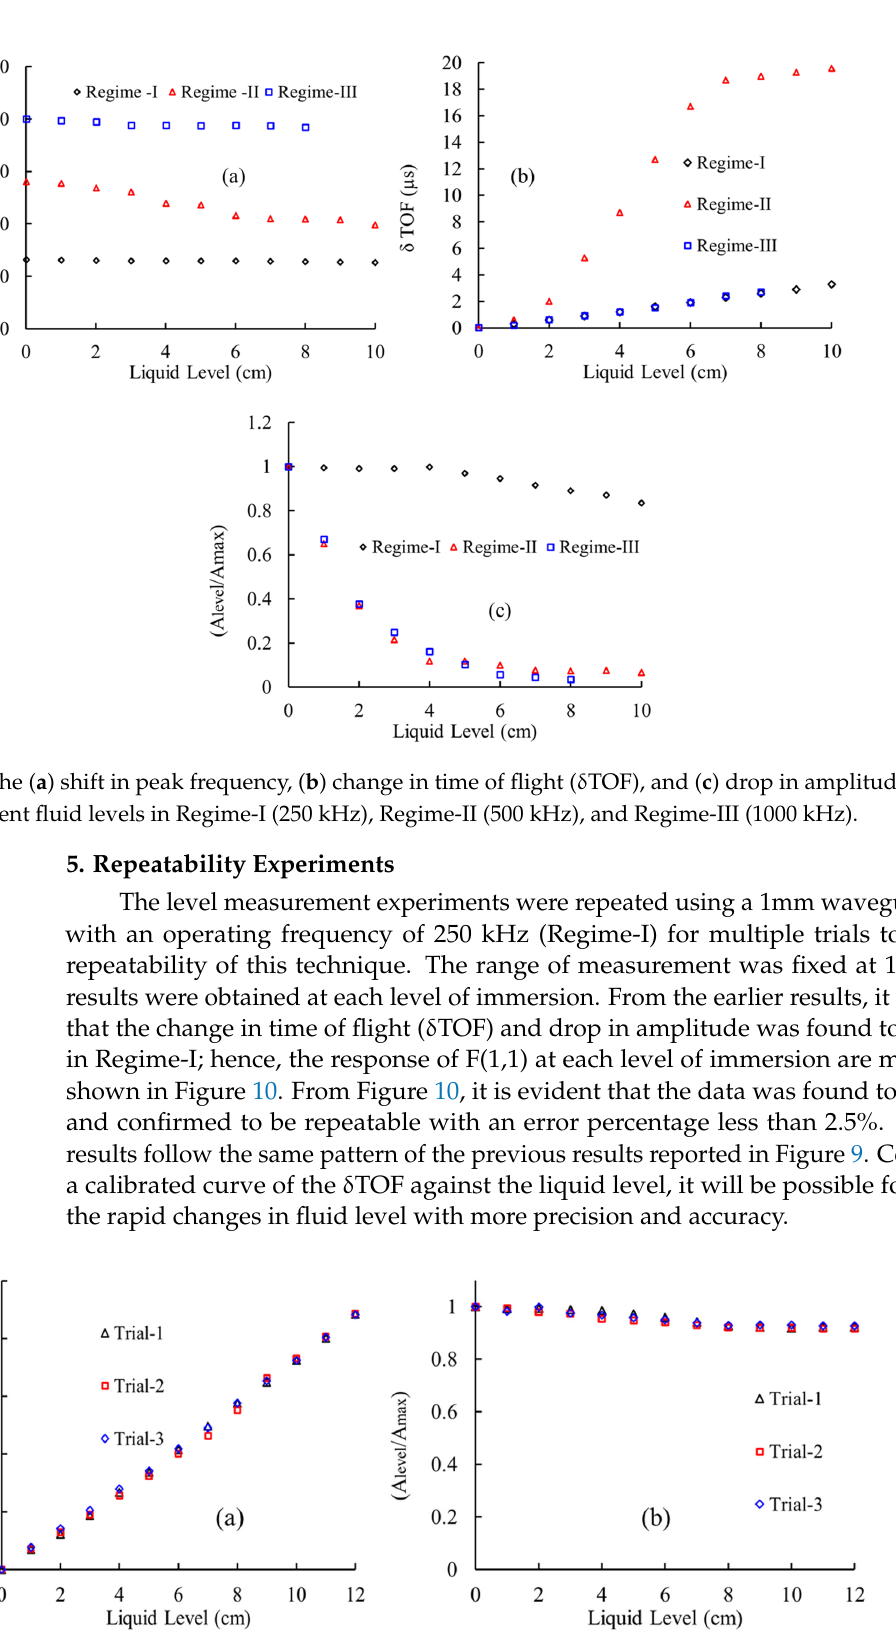
Figure 10. ( a ) Change in time of flight ( δ TOF) and ( b ) drop in amplitude of F(1,1) wave modes at different fluid levels in Regime-I (250 kHz) for different trials.